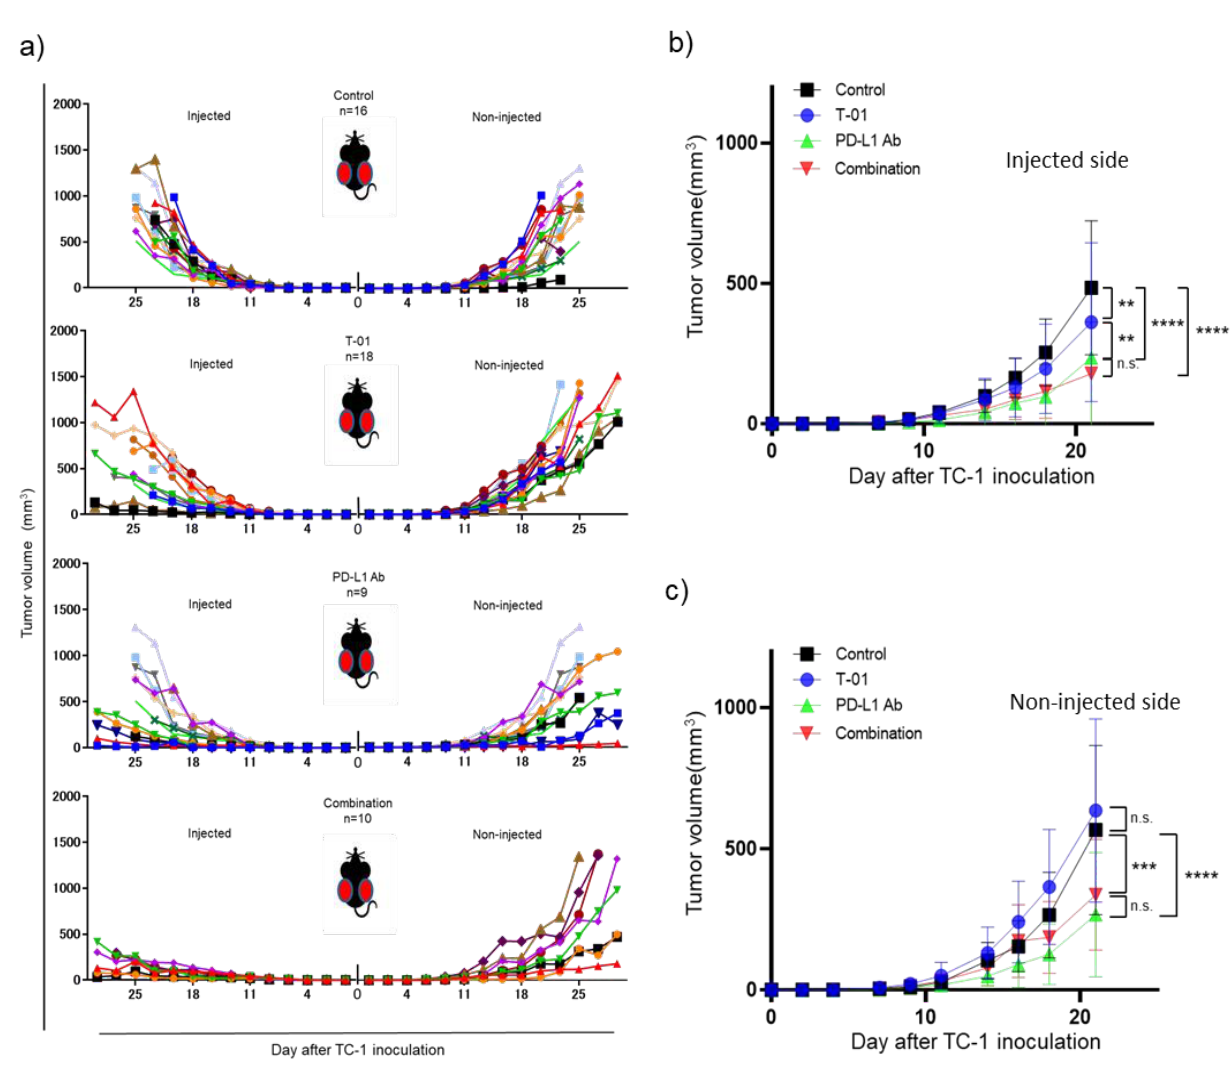
Figure 2. Efficacy of T-01 in combination with PD-L1 inhibition in a murine bilateral subcutaneous TC-1 tumor model. ( a ): Individual tumor growth curves of T-01 tumors. ( b ): Growth of TC-1 tumors in the T-01-injected side in animals. The results are presented as the mean ± SD ( n = 9 – 18 per group) (** p < 0.01, *** p < 0.001, **** p < 0.0001 n.s.: not significant). ( c ): Growth of TC-1 tumors in the